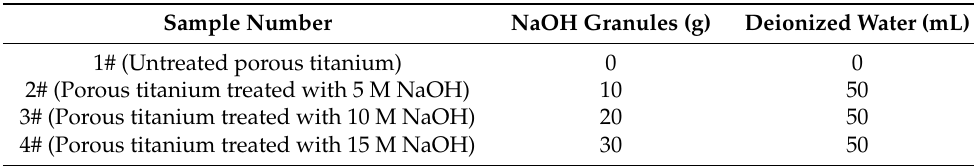
Table 1. The preparation and use of different NaOH concentration.